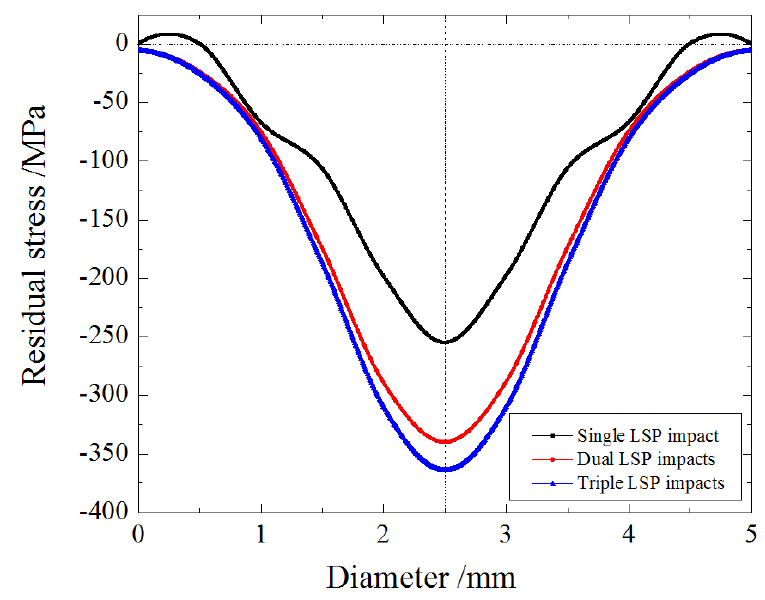
Figure 3. Surface residual stress distributions along the diameters of laser spots subjected to different LSP impacts.